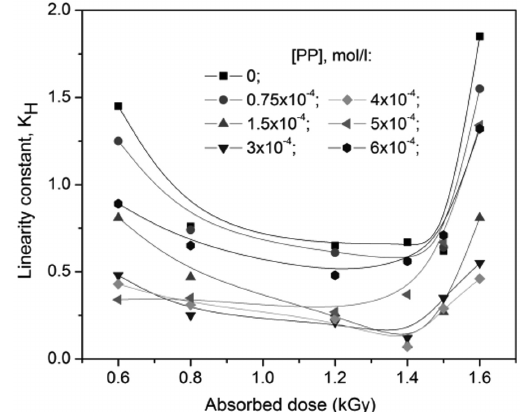
Figure 2. The effect of initiator concentration and EB absorbed dose on residual monomer content (M